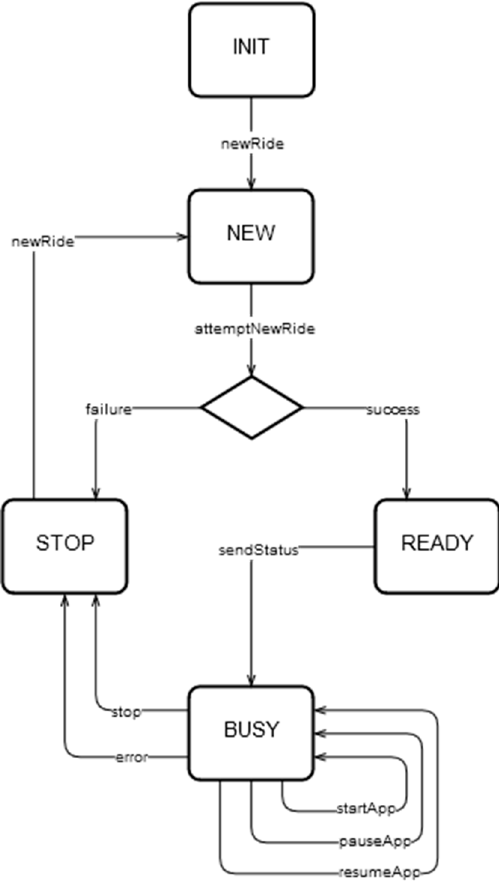
Figure 10. State machine of Raspberry Pi application.